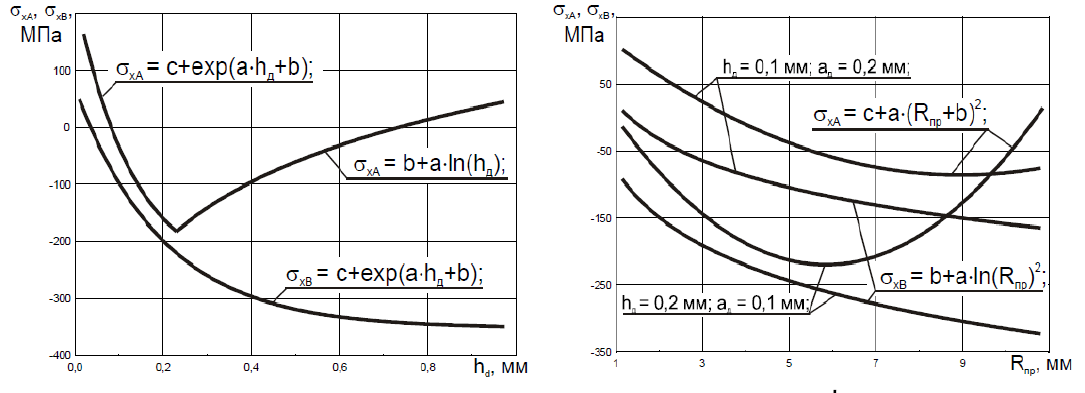
Fig. 2. Interrelationships of axial residual stresses on surface and in the first extremum: a - with real tension; b - with the profile radius of the